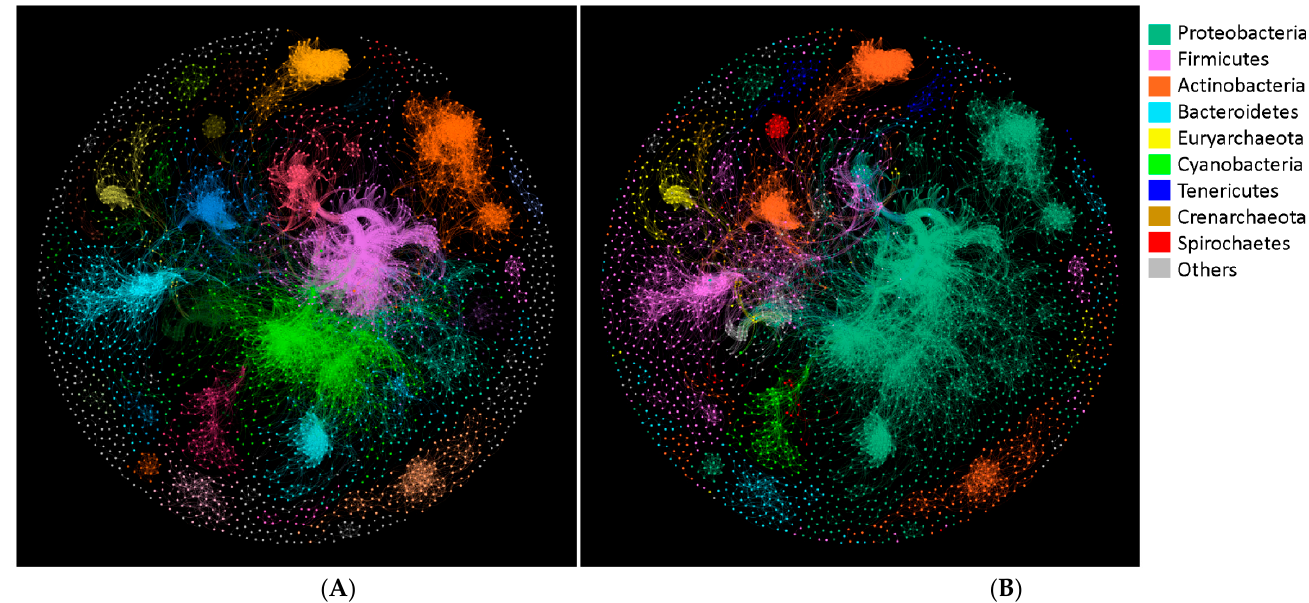
Figure 3. Network analysis of microbes using Gephi. ( A ) Primary modules were rendered with different colors and ( B ) microbes were distinguished by colors according to their affiliated phyla.